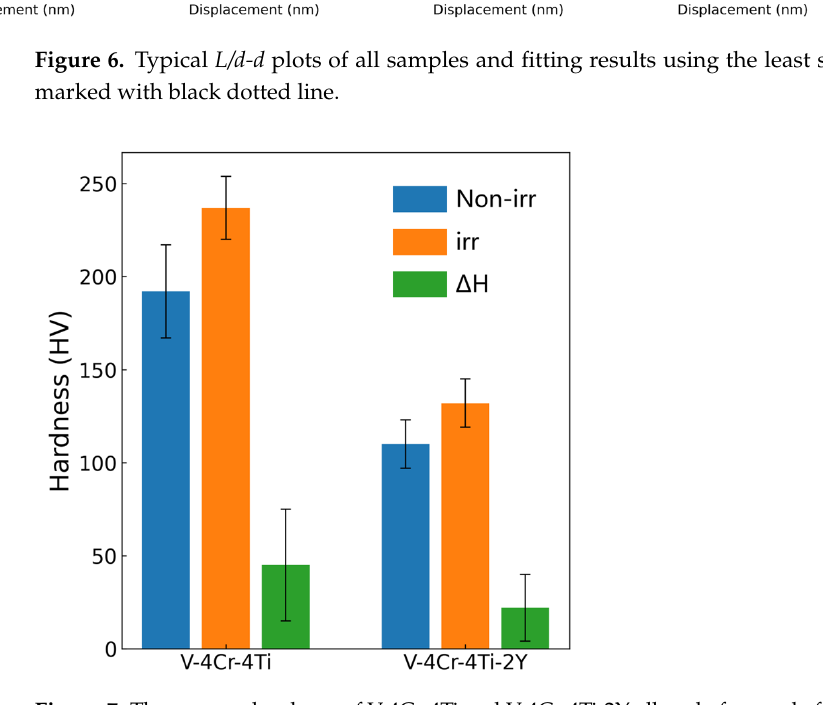
Figure 7. The average hardness of V-4Cr-4Ti and V-4Cr-4Ti-2Y alloys before and after D ion